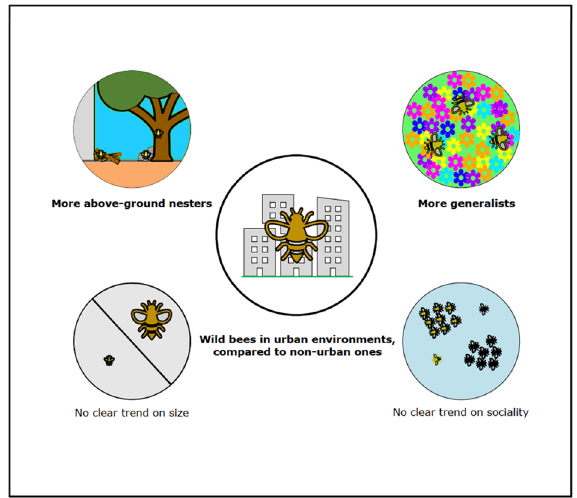
Figure 6. Summary picture of an urban bee community, compared to a non-urban one. This figure was generated using Inkscape v1.2 (https:// inksc ape.